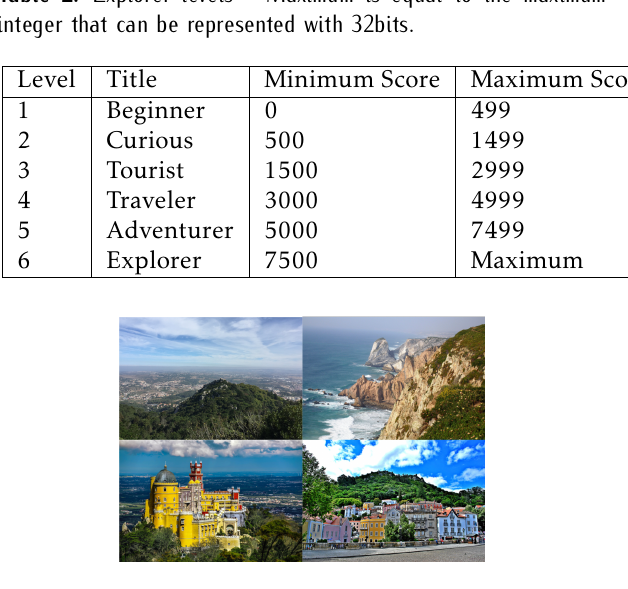
Figure 5. Sintra Mountains: several types of